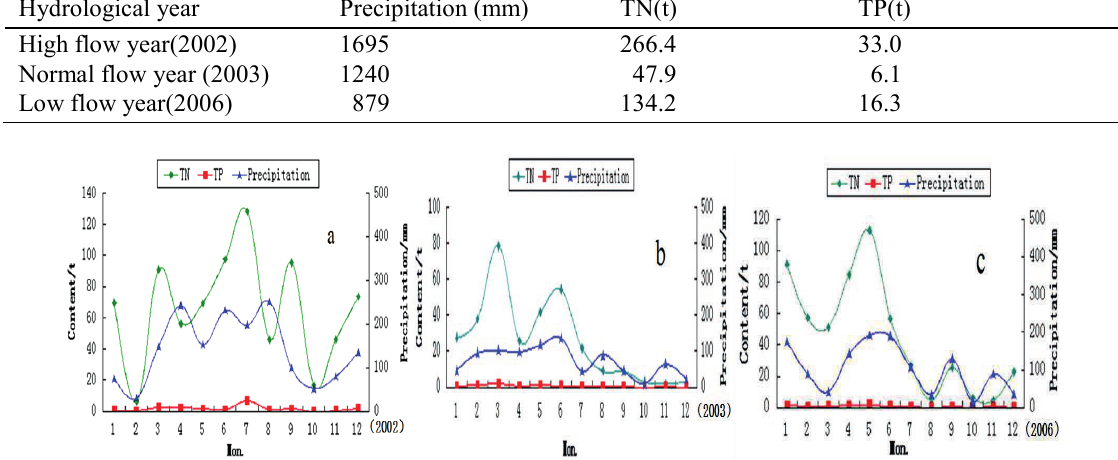
Fig. 5 The monthly distribution of precipitation and non-point source